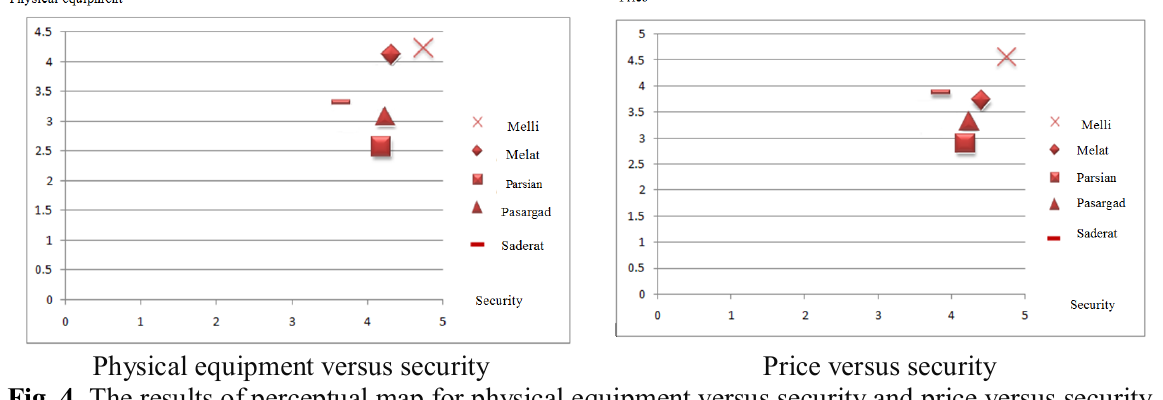
Fig. 4. The results of perceptual map for physical equipment versus security and price versus